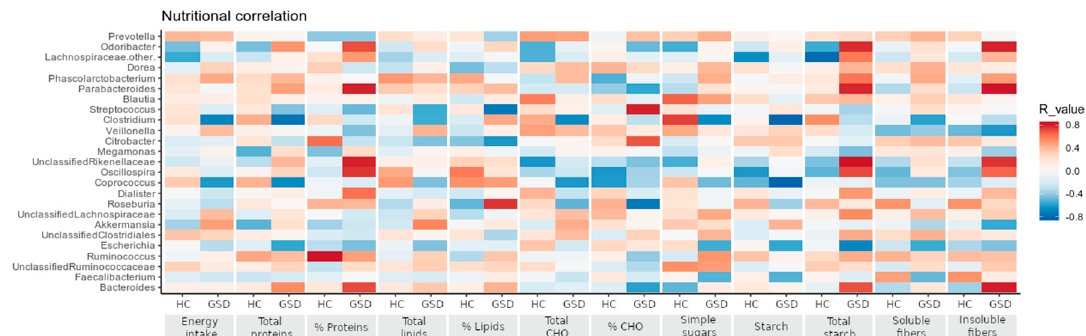
Figure 4. Correlations between nutritional and taxonomic values. Bacterial genera are reported in the same order of relative abundance as in Table 2, in correlation with the nutritional values shown in Table 1 according to Spearman’s correlation. Red tiles indicate a positive correlation, blue tiles a negative one for both HC and GSD groups.